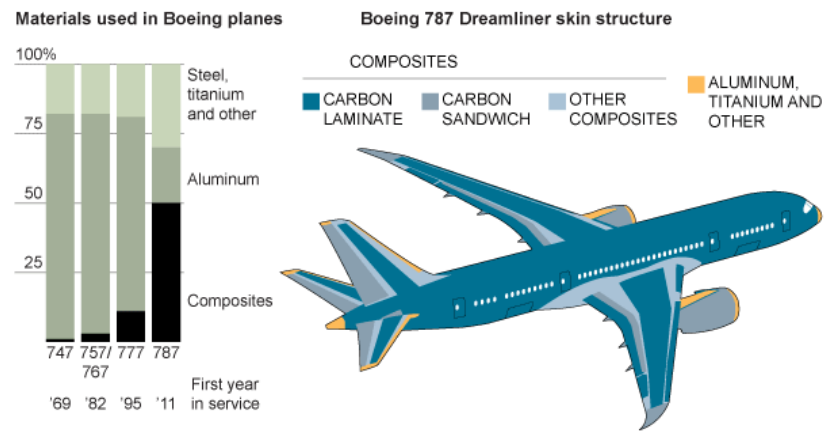
Figure 1. Materials used in the Boeing 787 Dreamliner skin structure [19].